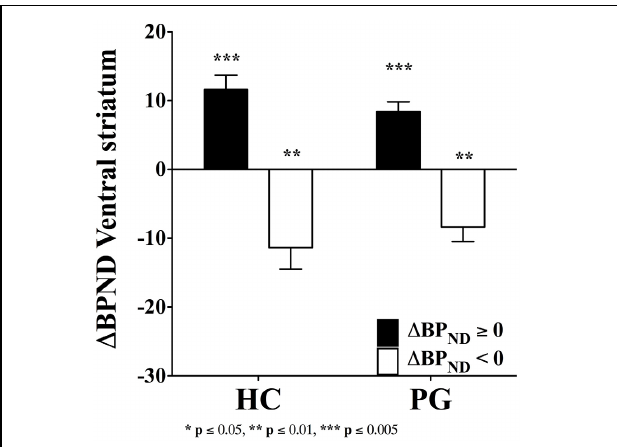
FIGURE 1 | Binding potential changes ( (cid:2) BP ND ) in ventral striatum. Gambling disorder sufferers (PG, n = 8) and healthy controls (HC, n = 5) show no significant differences in magnitude of dopamine release from baseline to gambling condition ( (cid:2) BP ND = 0, black bars). Similarly, gambling disorder sufferers (PG, n = 8) and healthy controls (HC, n = 9) show no significant differences in magnitude of dopamine inhibition from baseline to gambling condition ( (cid:2) BP ND < 0, white bars). The ordinate shows the change in binding potential ( (cid:2) BP ND ), while the error bars indicate Standard Error Means (SEM). Star symbols ( ∗ ) indicate p -values in comparison to baseline. Reprint with permission from Linnet et al. (2011b).